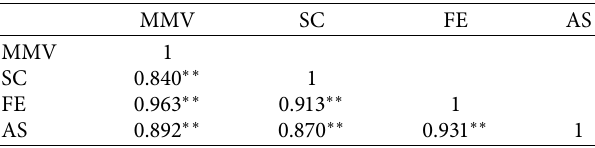
Table 2: Correlation